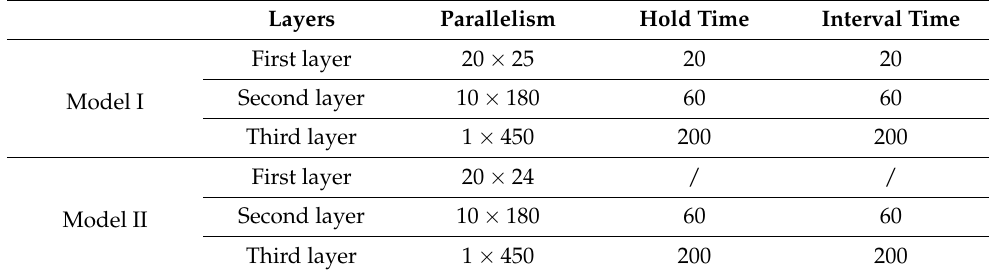
Table 3. Parallelization parameter setting.